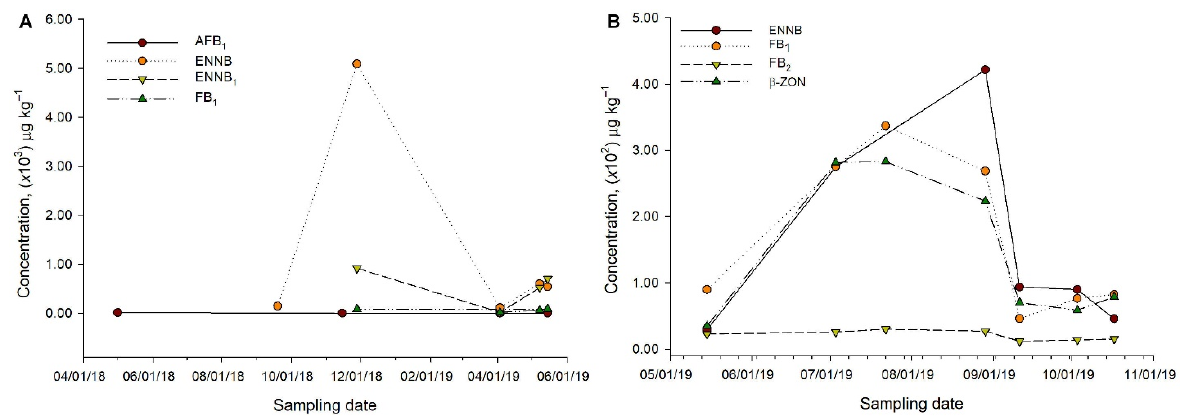
Figure 2. Analysis of the most relevant toxins during animal feed storage for ( A ) (supplier 1) and ( B ) (supplier 2). For supplier 1, the last sample tested exhibits a higher number of toxins n = 6 (FB 1 ,